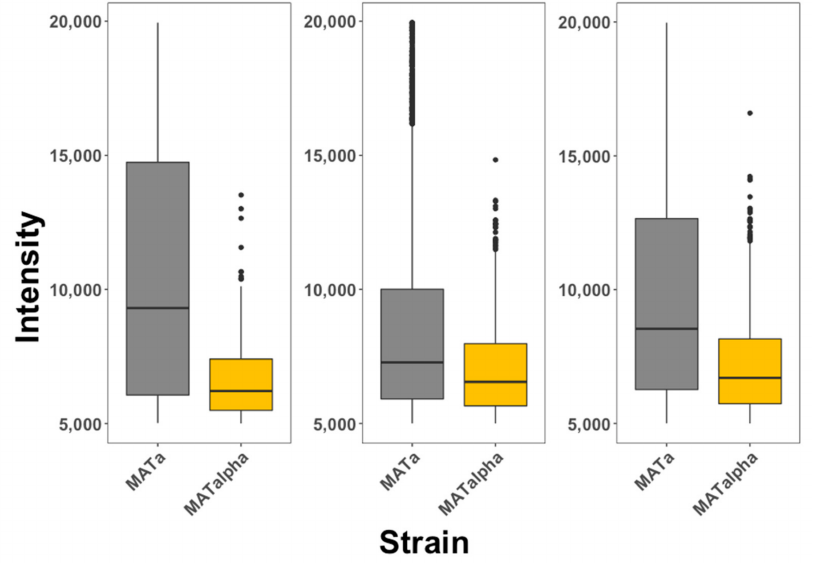
Figure 3. Internalization of selective CPPs on mixtures of yeast cells. MATa: RPL9A-GFP (gray) and MAT α (golden) cells were combined in a single vessel and exposed to α -NLS-C (left panel), NLS- α - CE (middle panel) and chimera (right panel) peptides. The degree of internalization is proportional to fluorescence intensity. The data is presented as box plots, where the second and third quartiles are presented below and above the dark horizontal line representing the median. The data represented in this plot is included as Table S2 and corresponds with 10,000 cells analyzed for each condition. These experiments were repeated at least 3 times for each